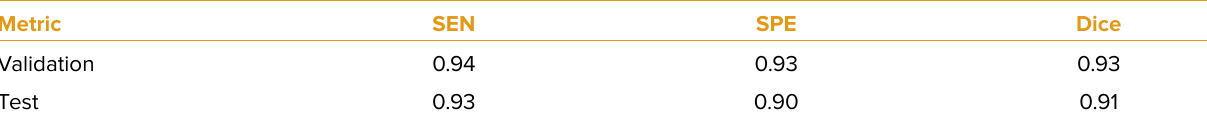
Table 1. DSC, SPE, and SEN value for U-net model on validation and test images.